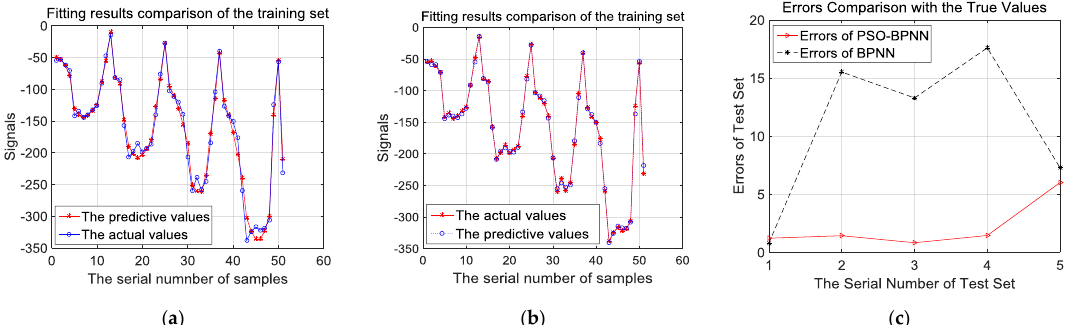
Figure 8. ( a ) Fitting results comparison of the training set by BPNN; ( b ) fitting results comparison of the training set by PSO-BPNN; ( c ) errors comparison of test set by BPNN and PSO-BPNN.